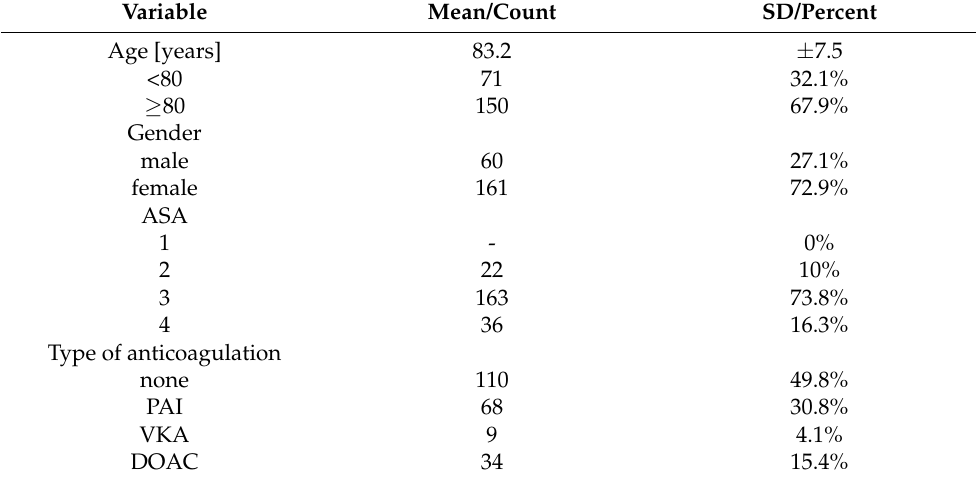
Table 1. Patient population.